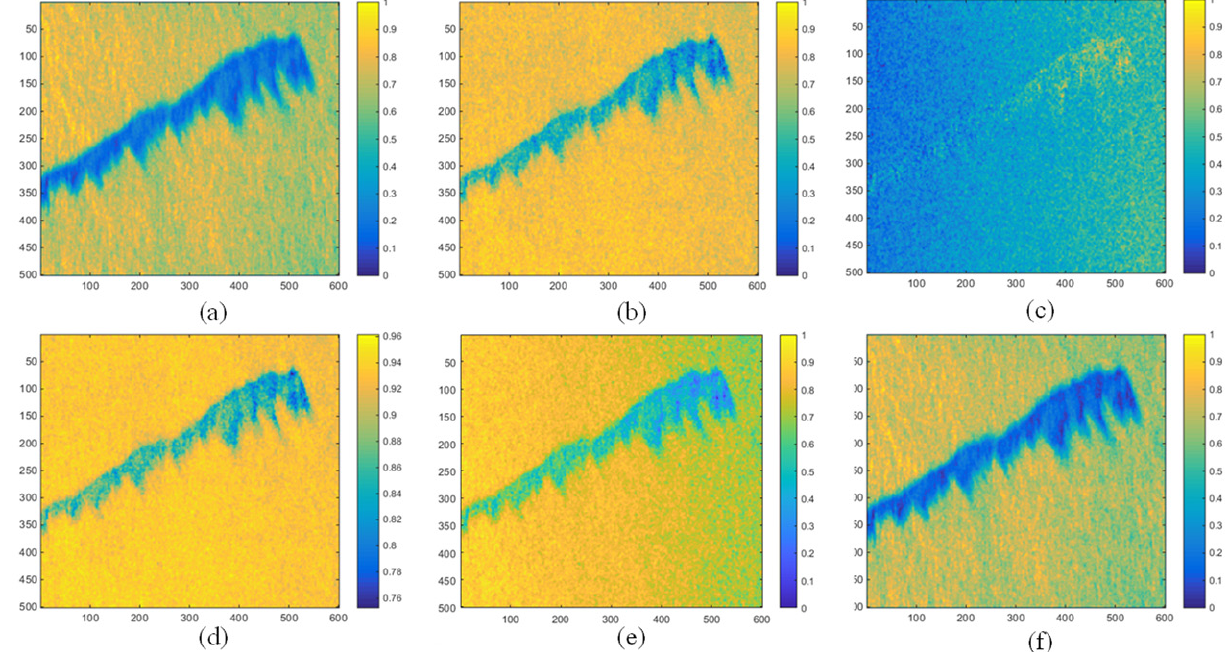
√ g 0 ; ( b ) 1 − H w ; ; ( b ) 1 − 𝐻 ; ( c ) (cid:3050) 0